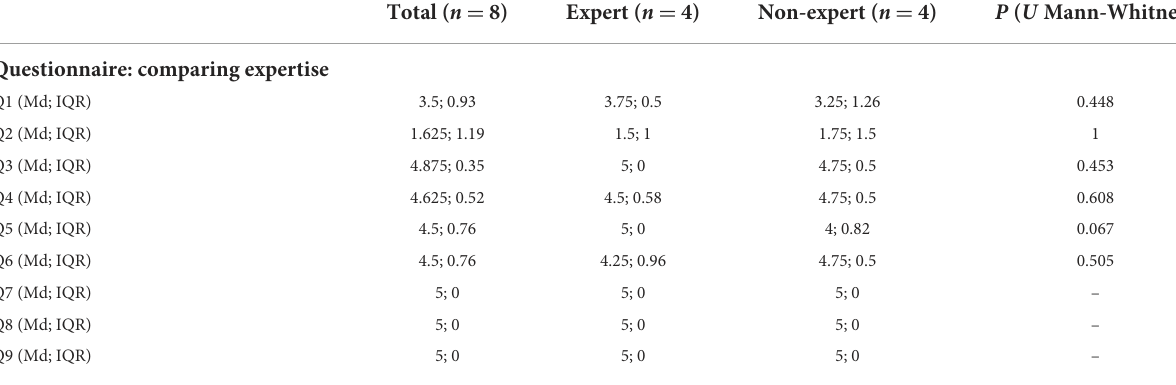
TABLE 8 Analysis of the questionnaire: comparing expertise. Total ( n = 8) Expert ( n = 4) P ( U